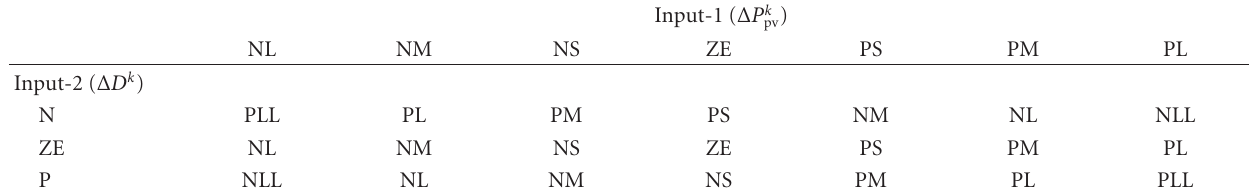
Table 1: Fuzzy rules for the proposed